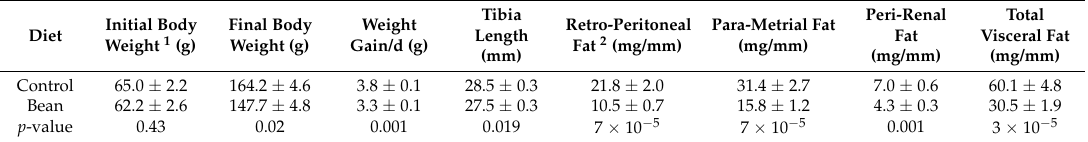
Table 1. Effect of ad libitum feeding of cooked whole bean diet on weight gain and visceral adiposity.